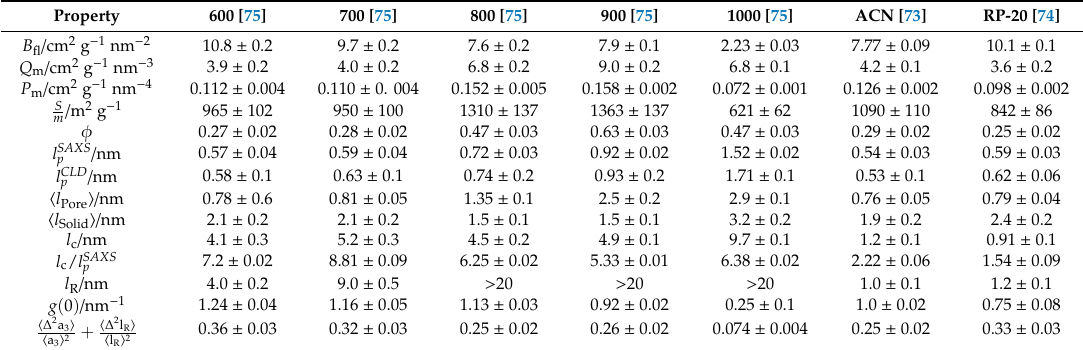
(cid:2189)((cid:2777))/nm − 1